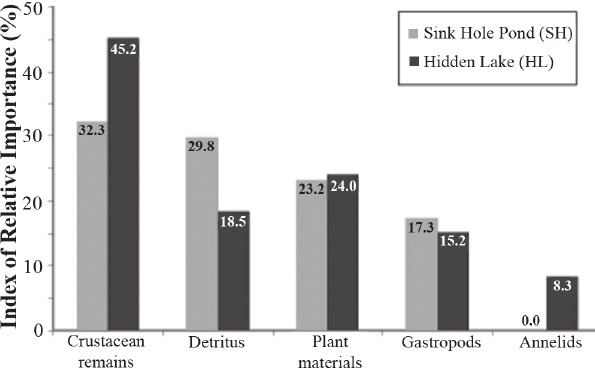
Fig. 2. Percent of index of relative importance values for Cichlasoma urophthalmus from Sink Hole and Hidden Lake